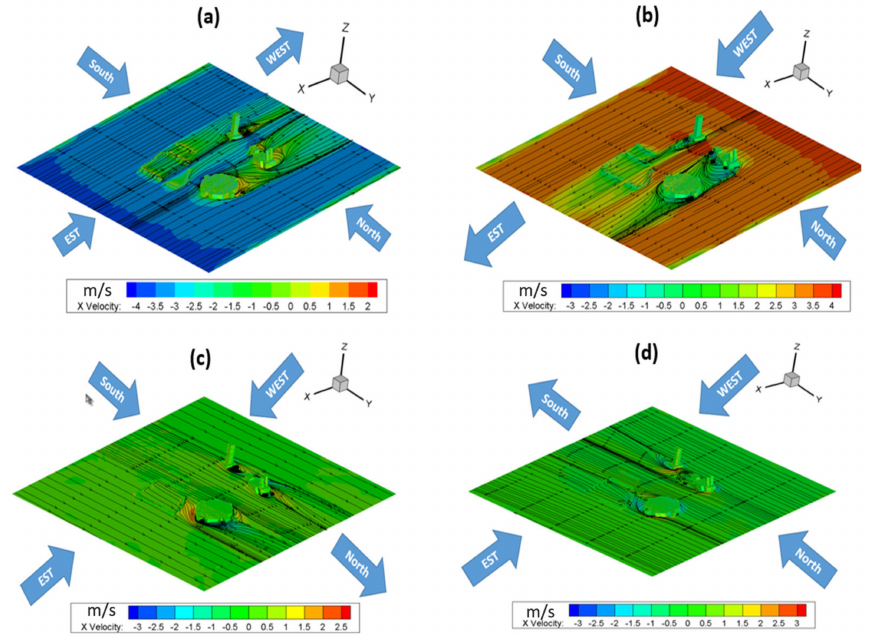
Figure 8. Streamlines and X velocity contours on the plane Z = 1.5 m: V = 4 m/s for the EST direction inlet ( a ), the WEST direction inlet ( b ), the SOUTH direction inlet ( c ), and the NORTH direction inlet ( d ).